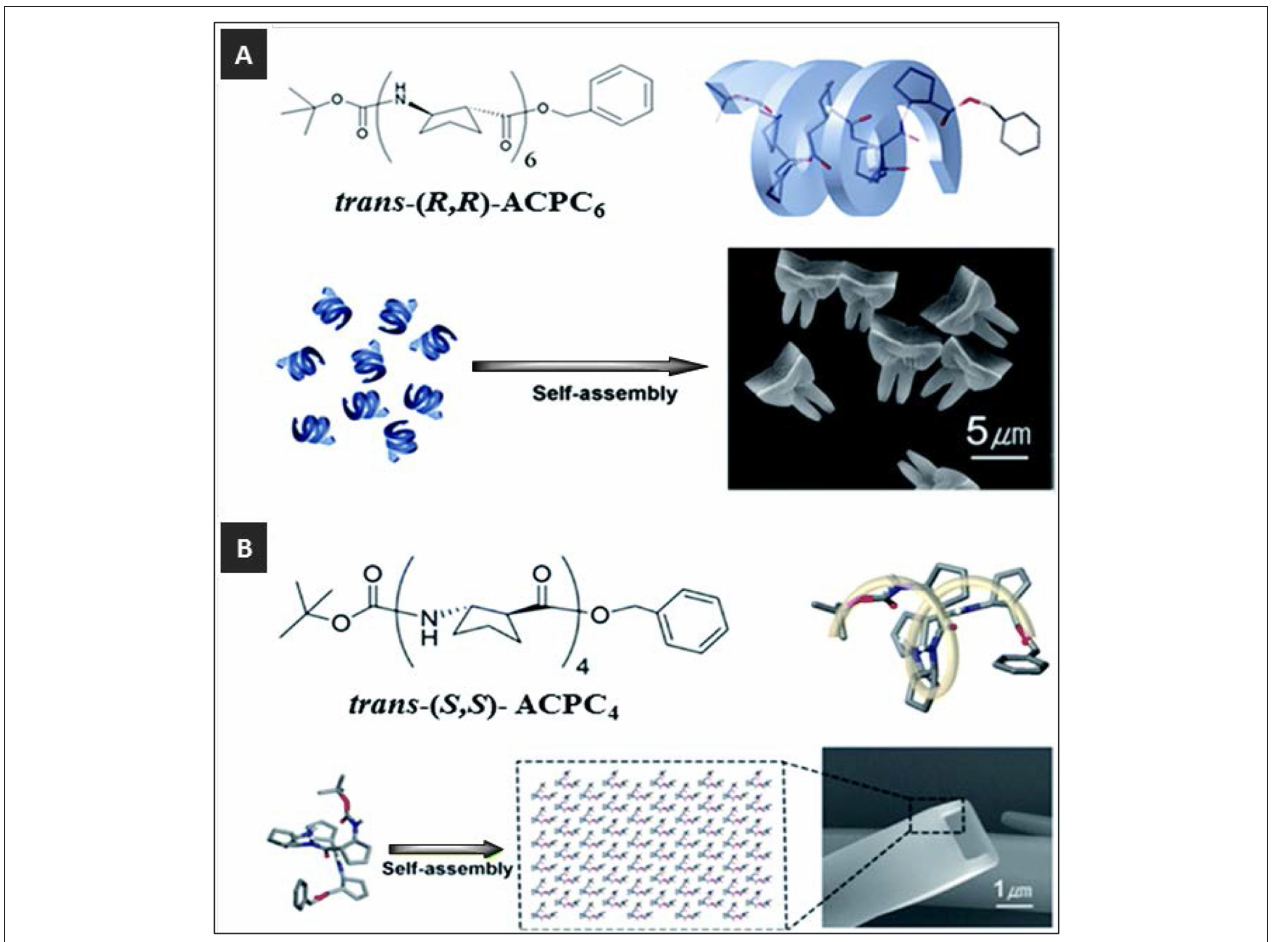
FIGURE 6 | (A) Self-assembly of tooth-shaped architectures from trans-(R,R)-ACPC 6 and (B) self-assembly of rectangular microtubes from trans-(S,S)-ACPC 4 . Adapted with permission from Kwon et al. (2011), Copyright 2011 American Chemical